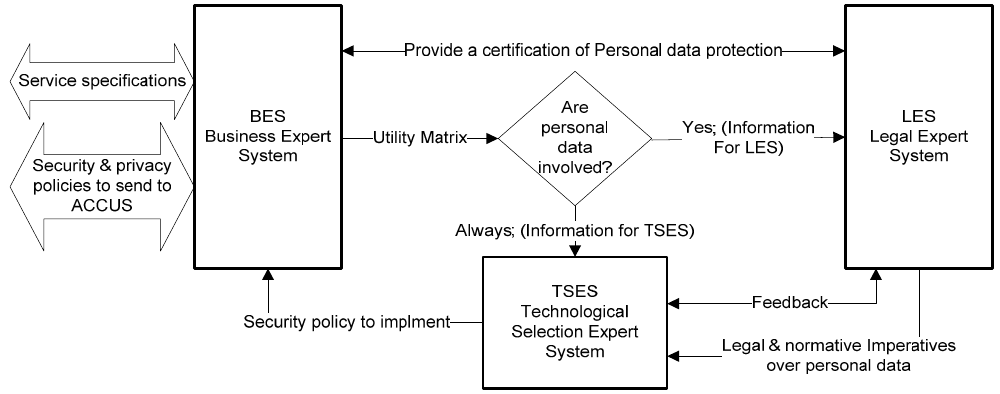
Figure 8. Expert System. Automatic Selection System for making decisions over security and privacy policies.